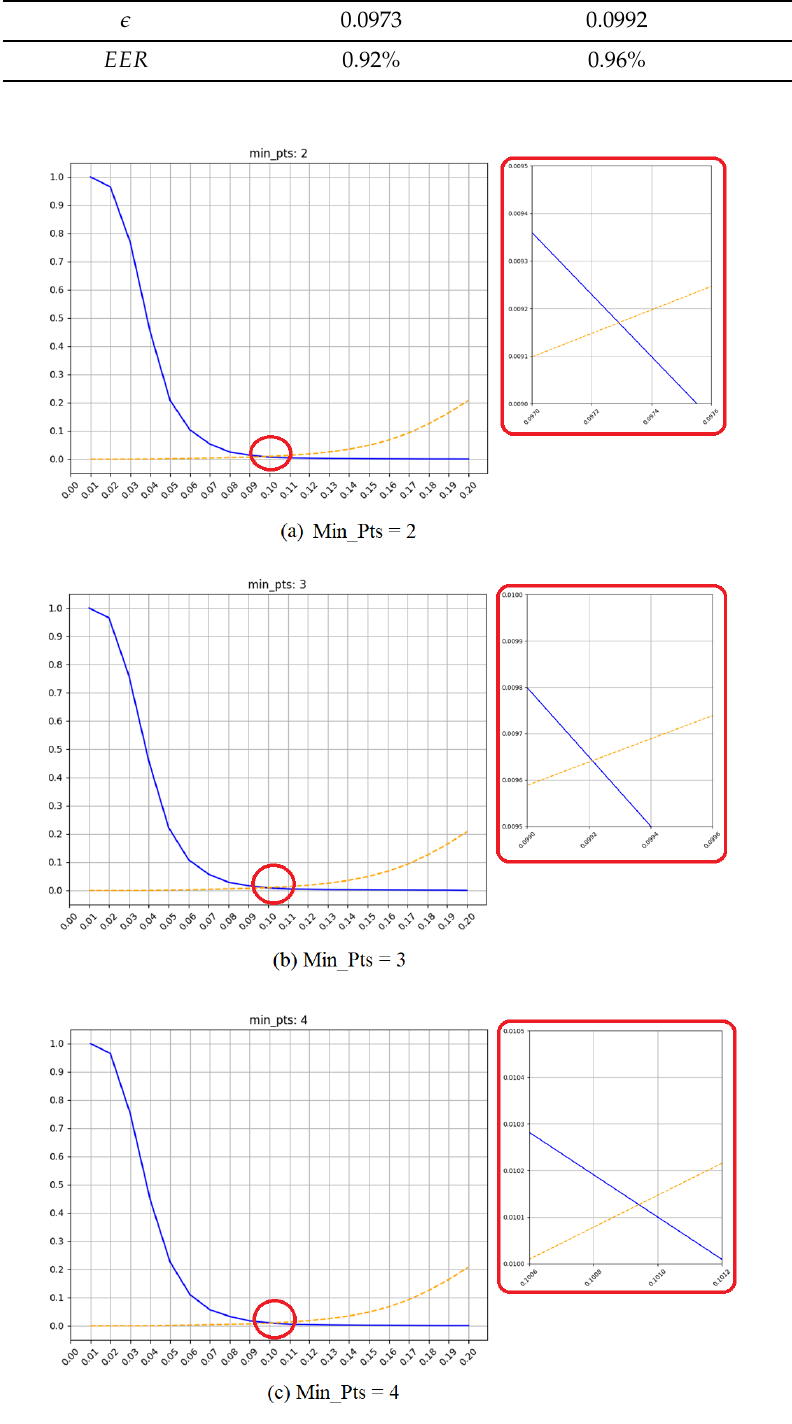
Figure 3. Results of One-Class DBSCAN. The blue is False Rejection Rate ( FRR ), and the orange dash is False Acceptance Rate ( FAR